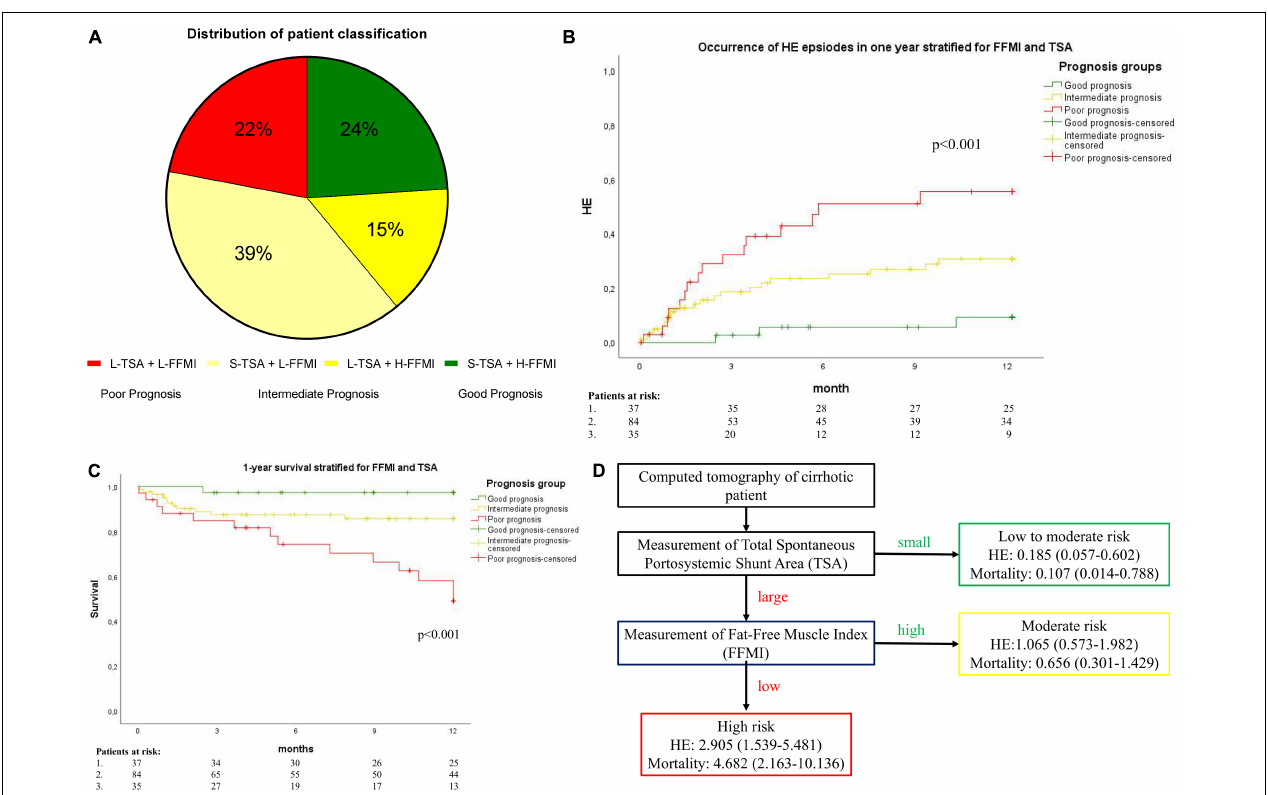
FIGURE 3 | (A) A pie diagram of patient distribution according to TSA and FFMI. H-FFMI (high FFMI); L-FFMI (low FFMI); S-TSA (small TSA); L-TSA (large TSA). (B) Cumulative incidence of the development of HE, and (C) A Kaplan–Meier survival analysis stratified by prognostic groups. The good prognosis [H-FFMI + S-TSA (small TSA); green line]; intermediate prognosis (L-FFMI + S-TSA and H-FFMI + L-TSA; yellow line); poor prognosis (L-FFMI + L-TSA; red line). P by log-rank. (D) Flow diagram of risk of hepatic encephalopathy (HE) and overall mortality stratified by TSA and FFMI. Hazard ratio and 95%-confidence interval are